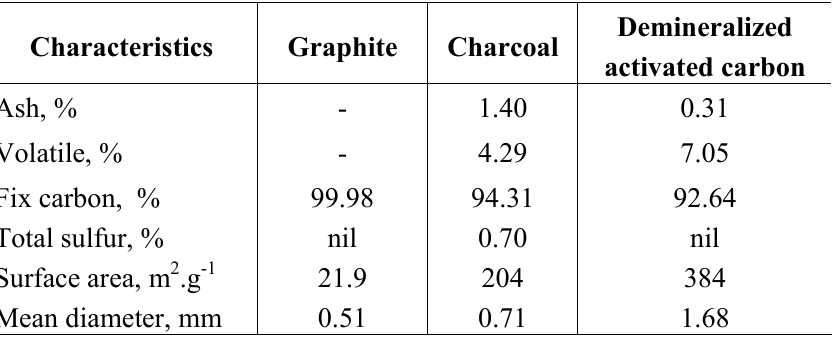
Table 1 . Characteristics of the carbon